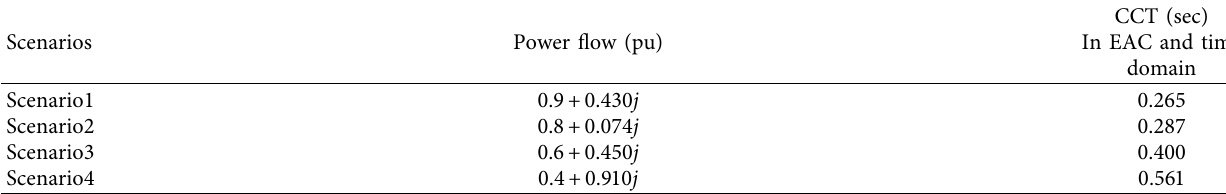
Table 2: Calculated and simulated CCT values with changing power.